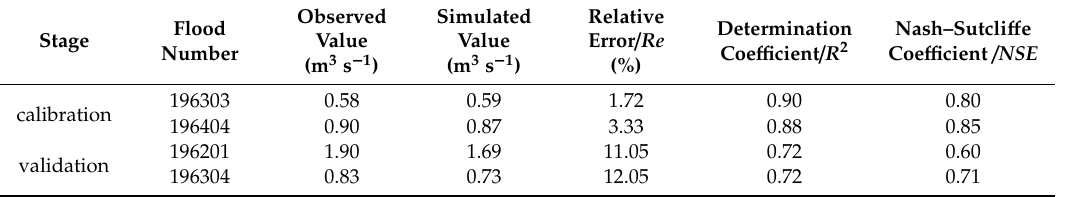
Table 1. Model calibration and validation results of the Wangmaogou watershed.